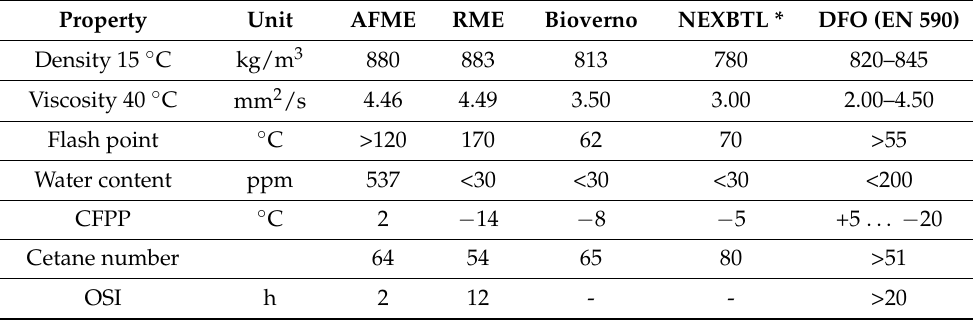
Table 1. Properties of the